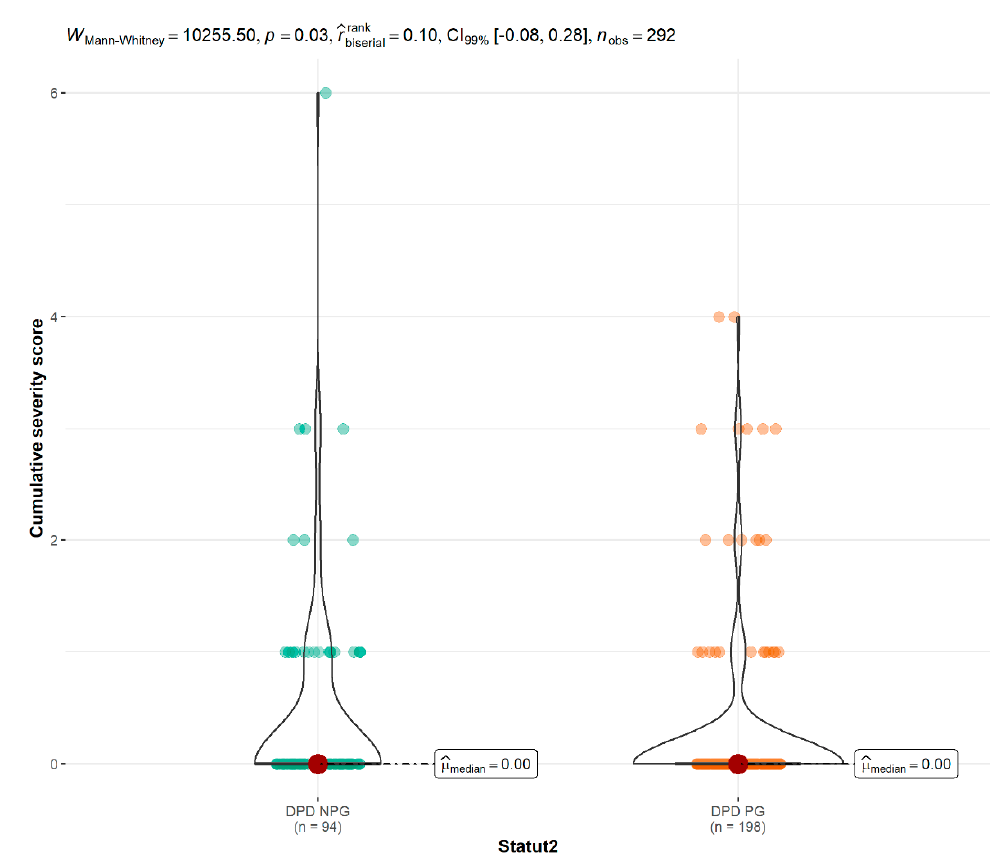
Figure 3. Comparison of cumulative severity scores between DPD PG and DPD NPG groups. DPD